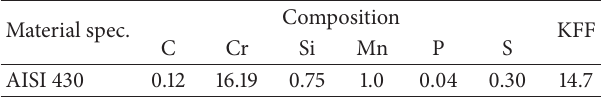
Table 1: Chemical composition of AISI 430 ferritic stainless steel (% by mass, balance Fe).